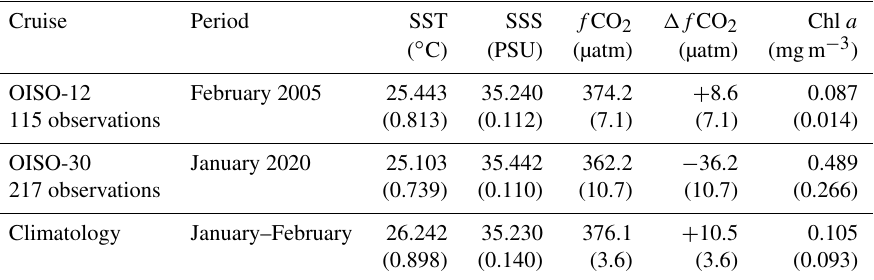
Table 2. Mean sea surface properties observed along the same track in January 2020 and February 2005 in the region 30–26 ◦ S, 54 ◦ E. Also indicated are the mean values in the same region and season from the climatology of Takahashi et al. (2014) and the Chl a climatology evaluated for January–February 1998–2019. The number of observations for SST, SSS and f CO 2 is indicated. Standard deviations are indicated in brackets. Cruise